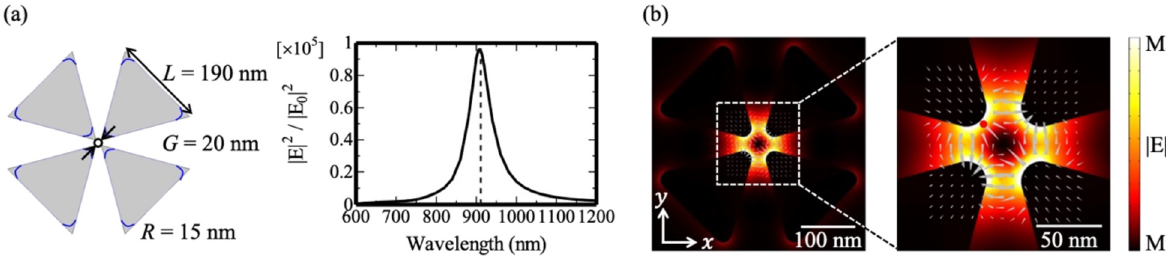
Figure 2: (a) Tetramer unit design and near-field spectrumin the gap region when illuminated by an on-axis cylindrical vector beam. (b) Near- fieldintensityprofilewithasnapshotoftheelectricfieldvectorat911nm.Thegraytrianglesindicatetheelectric fi eldvectorsandtheredpoint indicates the position where the spectrum of the near- fi eld intensity was measured.